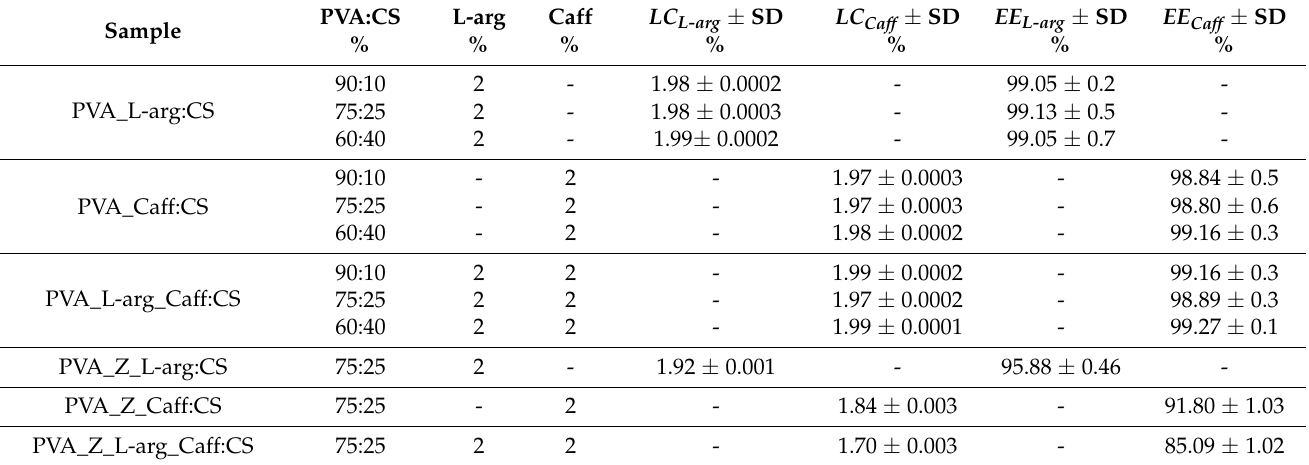
Table 1. Hydrogel loading capacity (LC) and entrapment efficiency.